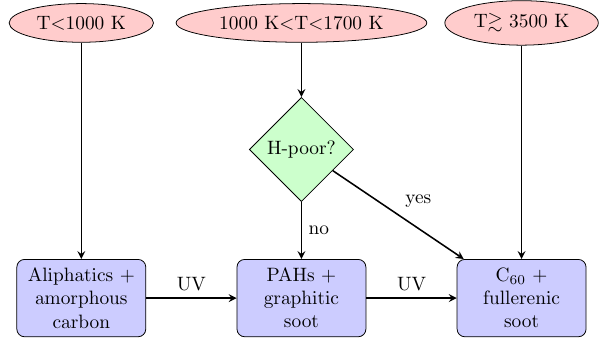
Figure 1. Formation routes for carbonaceous materials based on